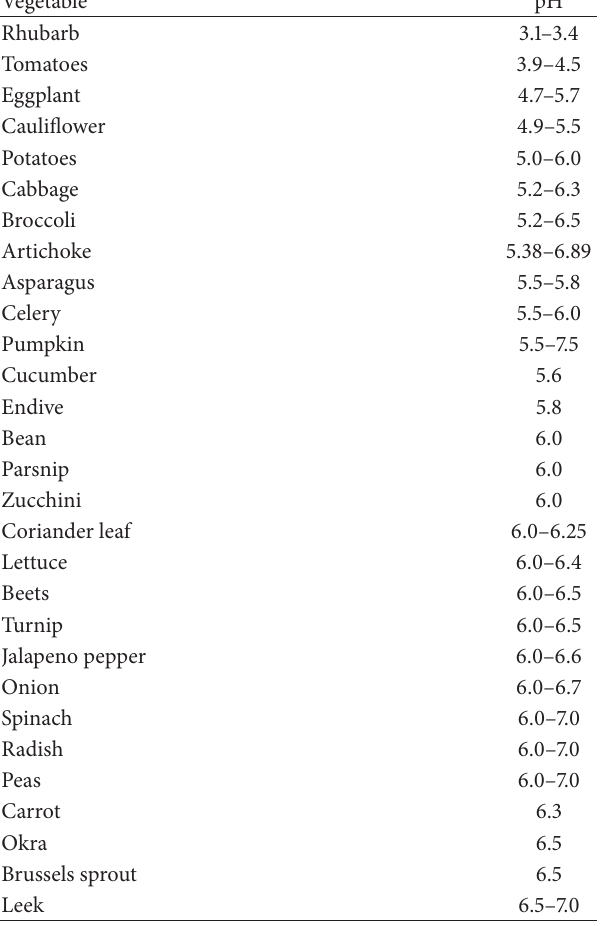
Table 1: pH values of selected